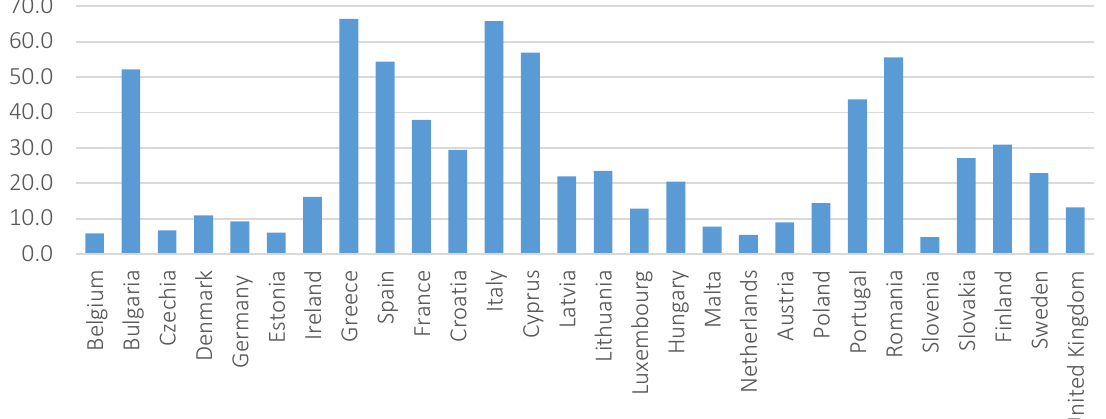
Figure 2. Involuntary part-time employment as % of total part-time employment